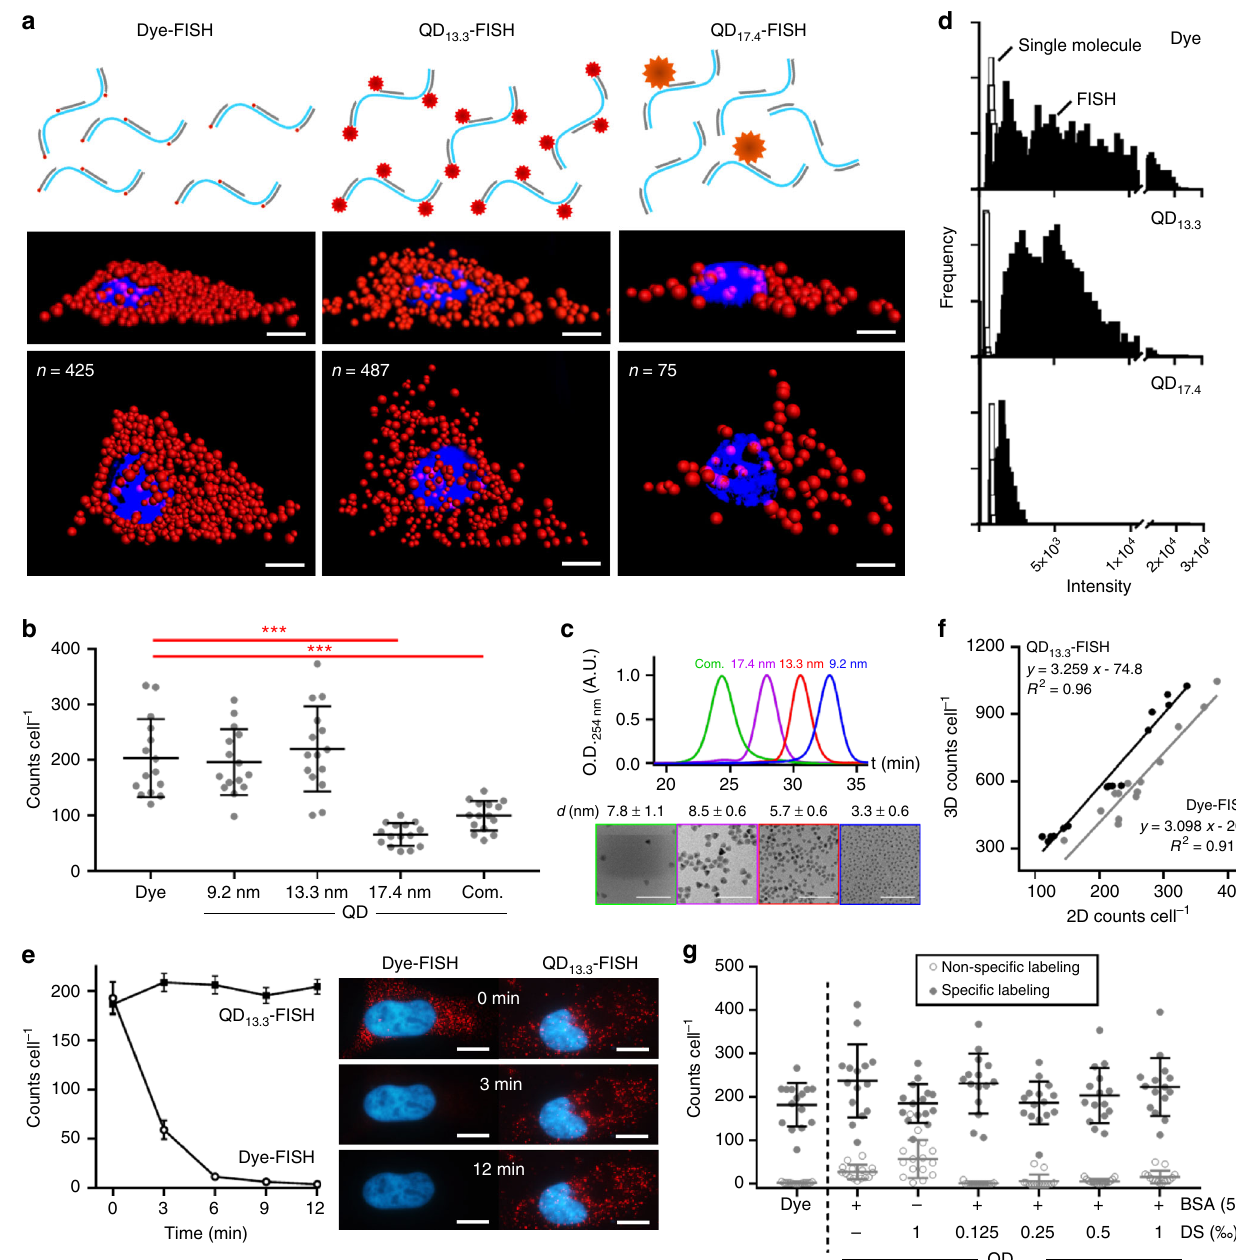
Fig. 1 Fluorescence in situ hybridization (FISH) using dye labels or quantum dot (QD) labels with diverse sizes. Data show HeLa cells stained for glyceraldehyde-3-phosphate dehydrogenase ( GAPDH ) transcripts. a Schematics show RNA target labeling density; representative 3D deconvolved epi fl uorescence images show cells in two orthogonal orientations, using dyes, small QDs (13.3 nm), or big QDs (17.4 nm). Scale bar = 8 μ m. b FISH transcript counts (2D) using dyes, custom designed QDs with three hydrodynamic diameters (9.2, 13.3, or 17.4 nm), or commercially available QDs (com.). Asterisks indicate: p ≤ 0.05 (*), p ≤ 0.01 (**), and p ≤ 0.001 (***); Student ’ s t -test. N = 15. Comprehensive statistical comparisons are provided in Supplementary Table 2. c Gel permeation chromatograms and TEM images (with core size) of the four QDs from panel b. Scale bar = 50 nm. d Intensity histograms of FISH spots for dyes, small QDs (13.3 nm), and big QDs (17.4 nm) are shown in black compared with histograms of single- fl uorophore intensities in white. e FISH counts after different times of laser excitation, comparing stability of QD 13.3 and dyes, including representative images. Scale bars = 10 μ m. N = 15. f Correlation between FISH counts in 2D and 3D images for QD 13.3 and dye labels. Comprehensive statistical comparisons are provided in Supplementary Table 1. g Impact of customized blocking conditions on speci fi c and nonspeci fi c labeling. Nonspeci fi c labeling counts (2D) for QDs were statistically the same as those of background when applying both 5% bovine serum albumin (BSA) and 0.125 ‰ dextran sulfate (DS). N = 15. All error bars represent